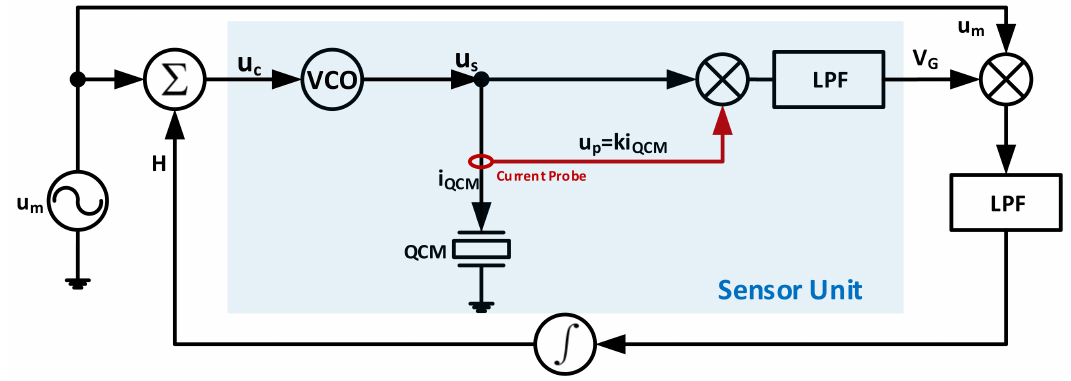
Figure 19. Maximum conductance PLL block diagram from